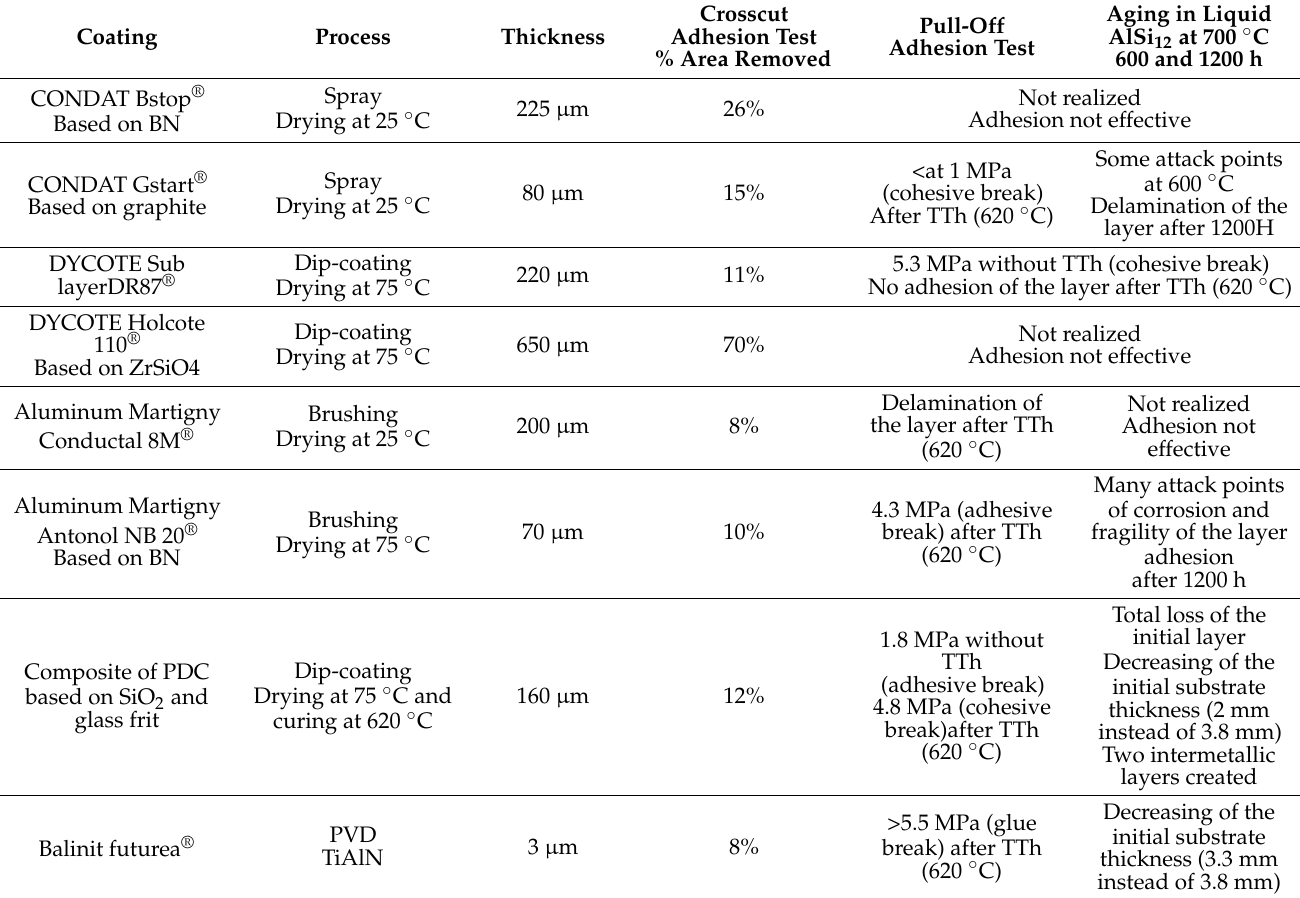
Table A1. Preliminary tests of several coatings.